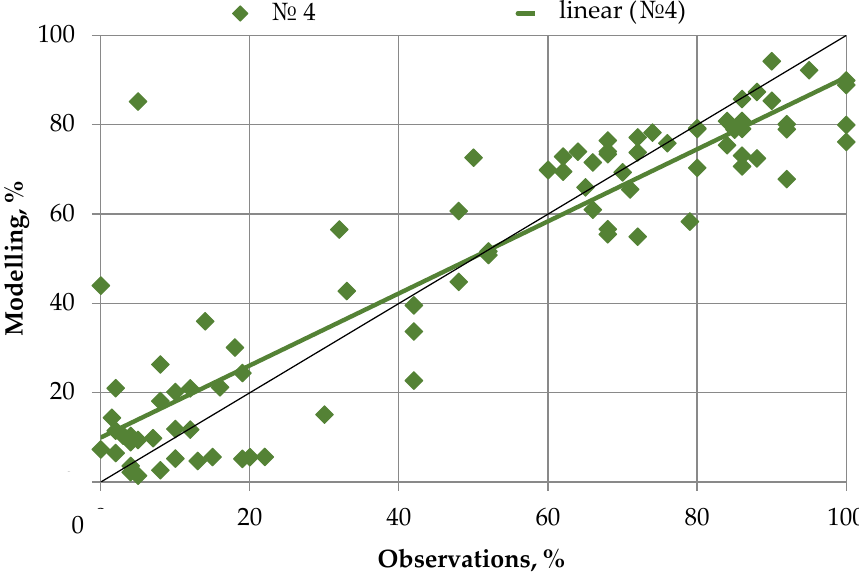
Figure 6. Scatter of modeling residuals in relation to experimental data for wells type No. 4.